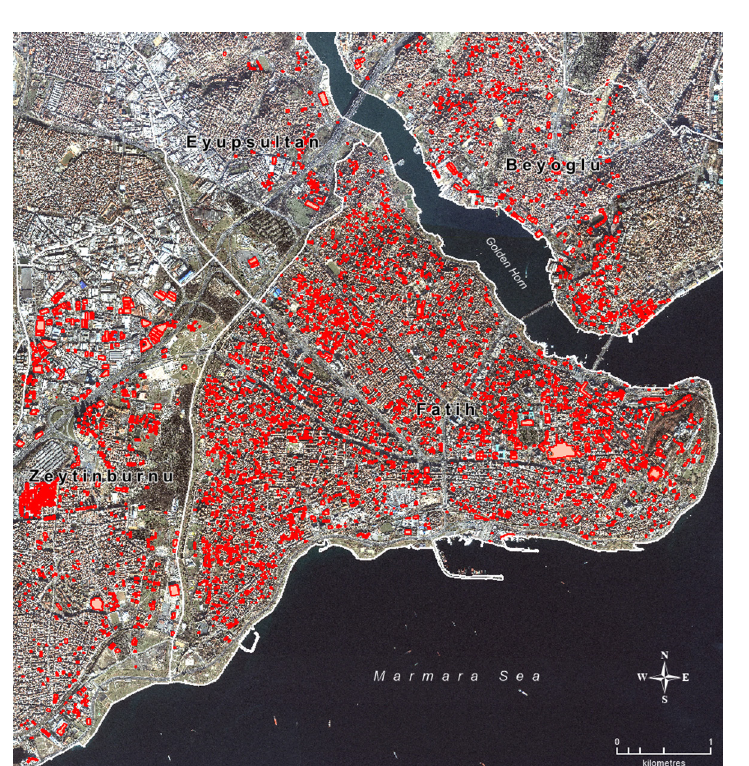
Fig. 5. One-to-one matched